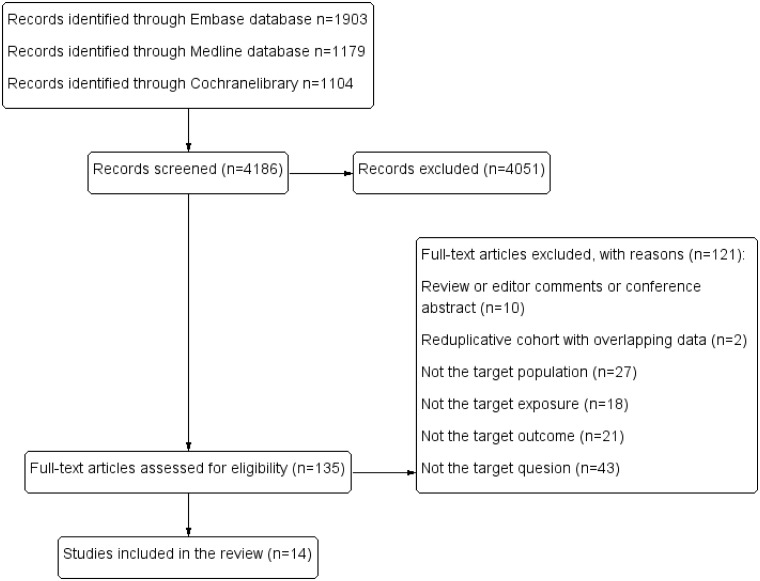
Flowchart of literature search.